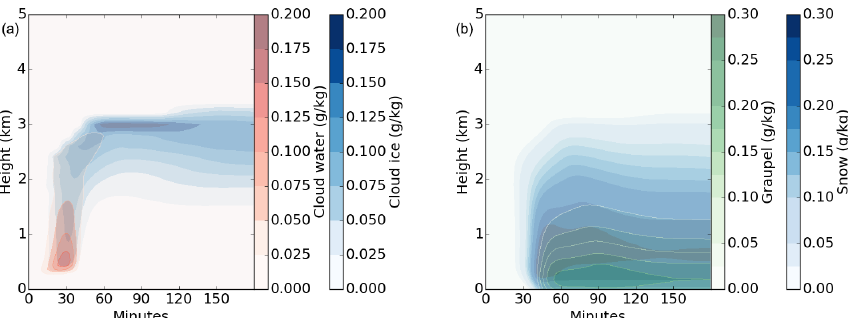
Figure 4. Time-height cross-section of (a) cloud water and cloud ice and (b) rain, snow + graupel in the single-column freezing drizzle